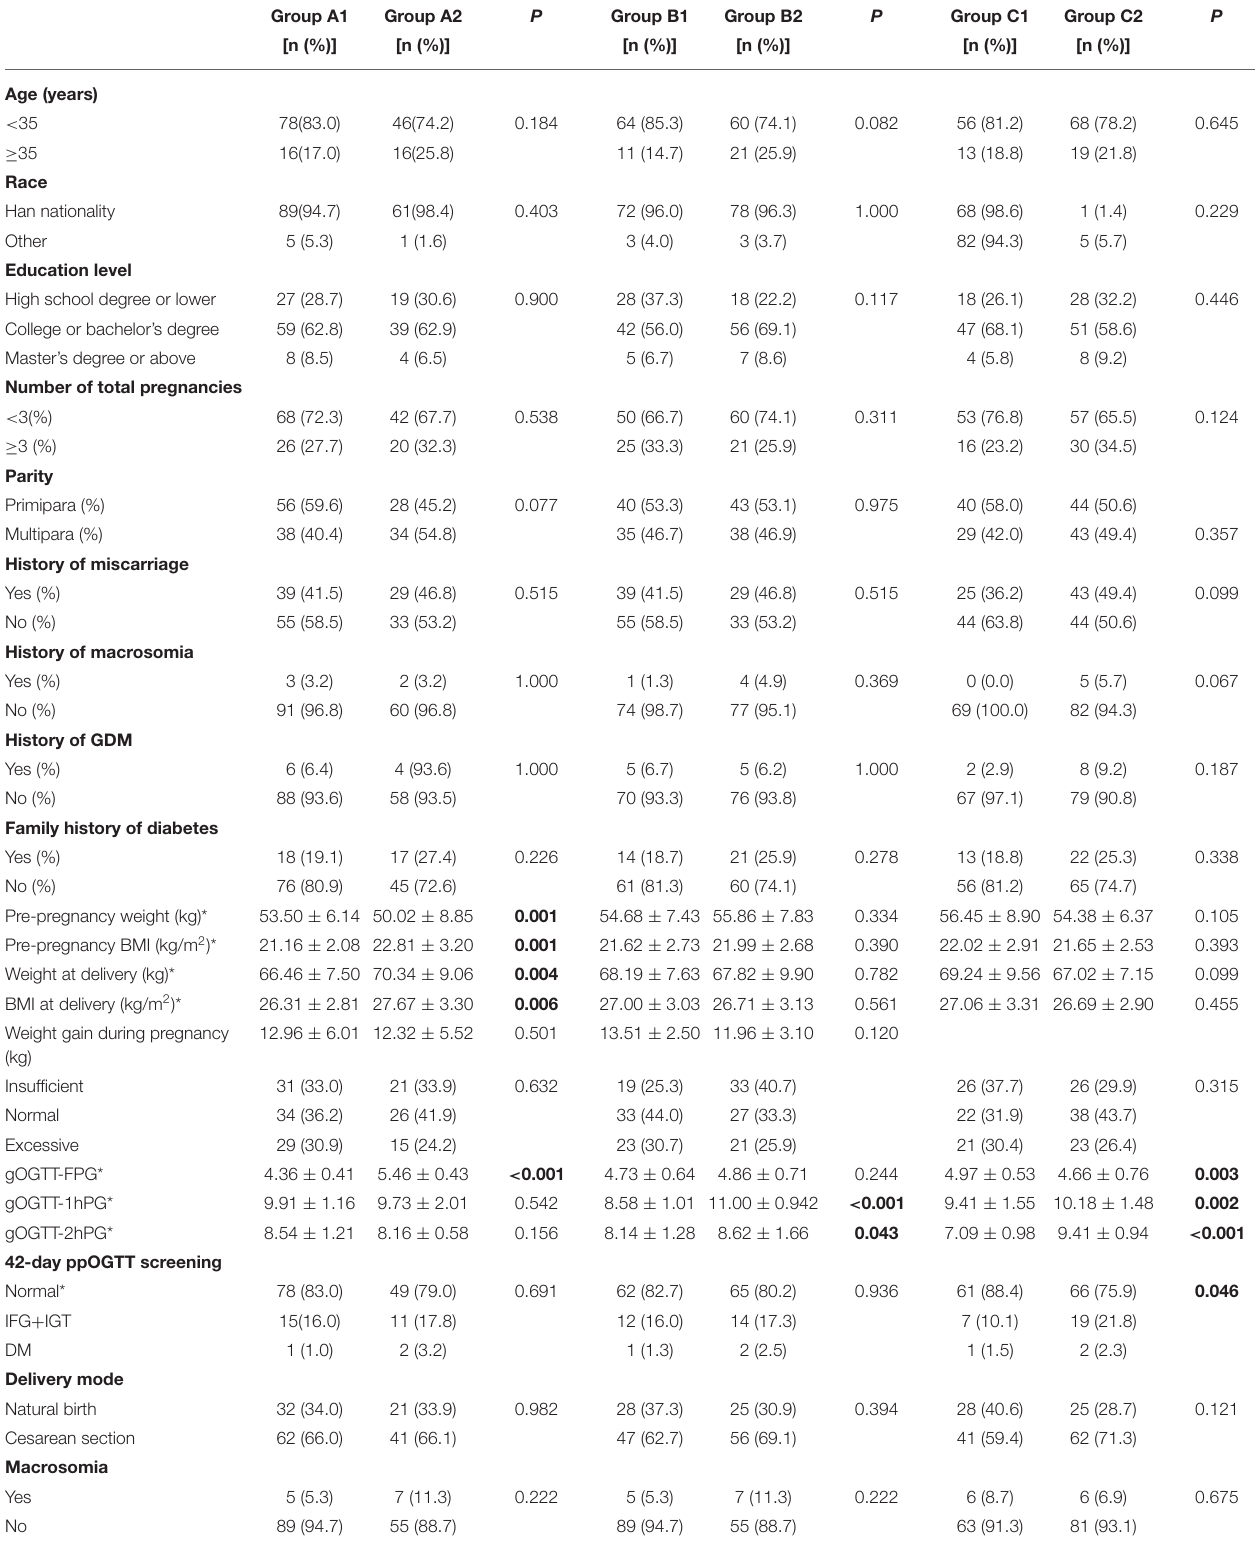
TABLE 3 | Comparisons of various characteristics according to OGTT classification. Group A1 Group